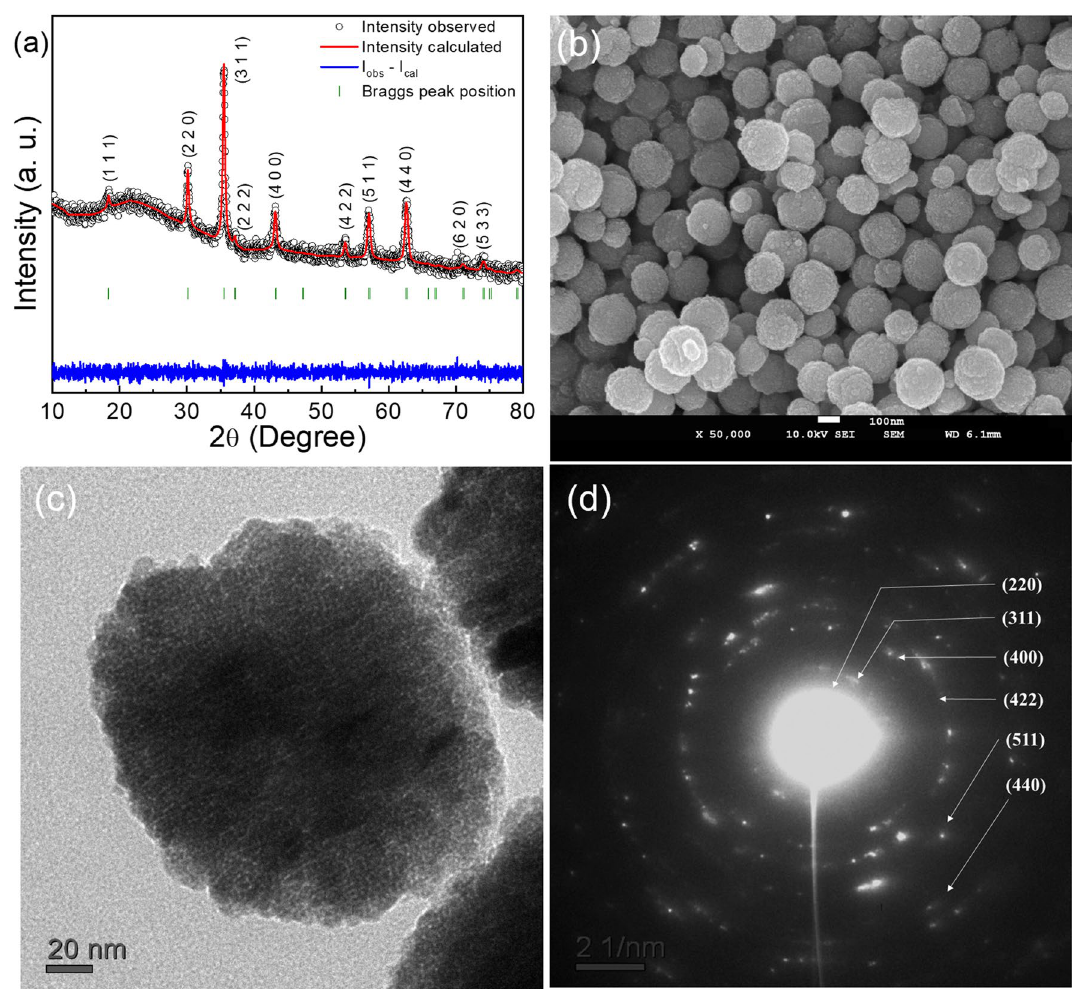
Figure 1. The XRD pattern and the Rietveld refinement profile using the Fullprof program ( a ), FE-SEM micrograph ( b ), TEM micrograph ( c ), and SAED pattern of MNS ( d